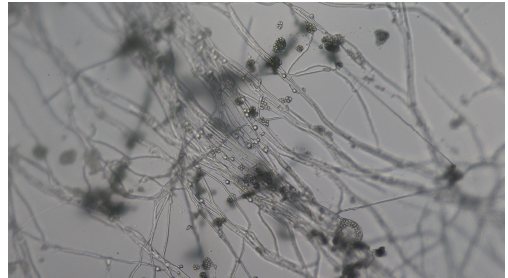
Figure 3. Trichoderma reesei , Olympus BX41, 100x.